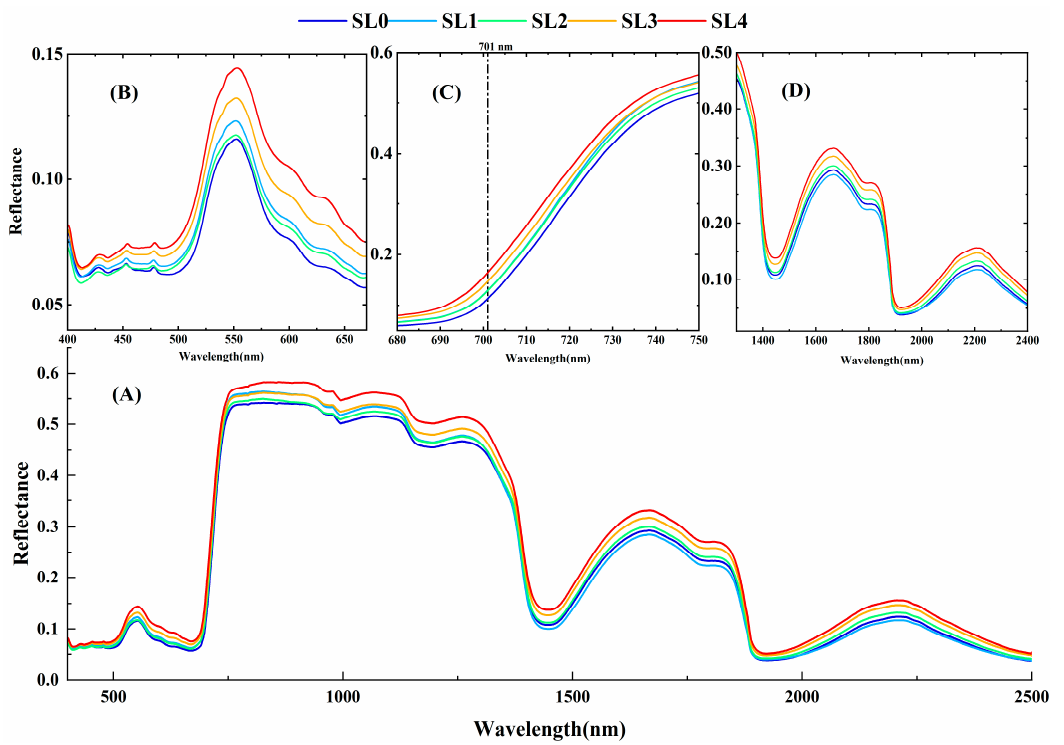
Figure 3. Spectral characteristics of cotton VW leaves. ( A ) Spectral reflectance of cotton leaves under different VW disease degree between 350 and 2500 nm, ( B ) spectral reflectance of cotton leaves under different degrees of VW disease in visible light (400–675 nm), ( C ) spectral reflectance of cotton leaves under different degrees of VW disease at the red edge of visible light (680–750 nm), ( D ) spectral reflectance of cotton leaves under different degrees of VW disease in short-wave infrared light (1300–2400